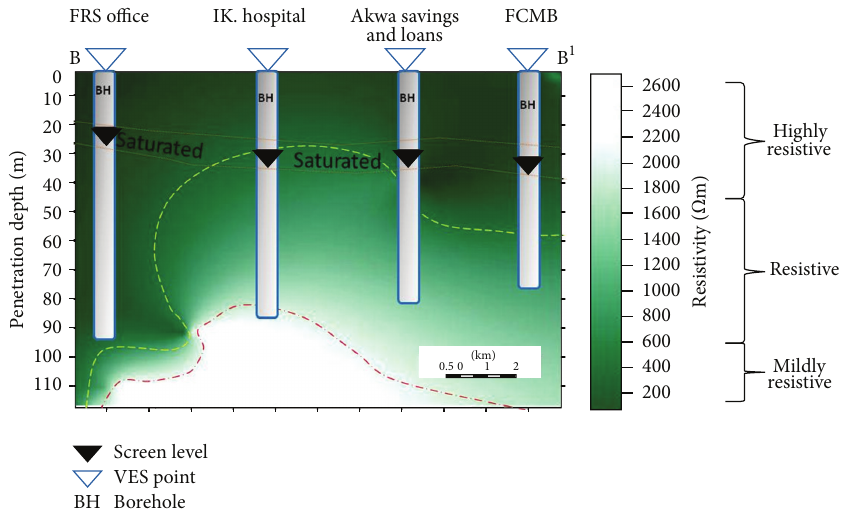
Figure 6: Resistivity cross section along a profile from FRS Office to FCMB (B-B 1